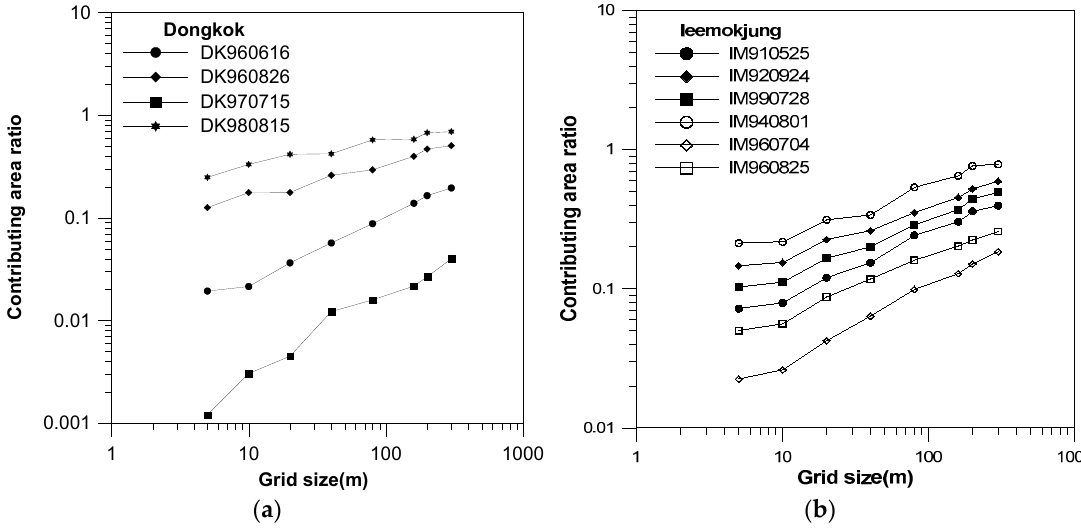
Figure 7. Change in the ratio of the contributing area based on the DEM grid cell size. ( a ) Dongkok watershed. ( b ) Ieemokjung watershed.